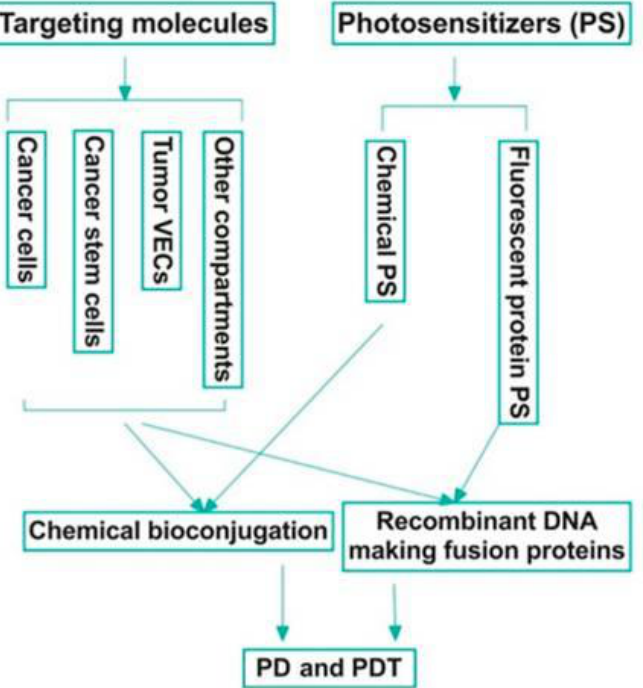
Figure 5. Bioconjugation strategies in photodiagnosis (PD) and therapy (PDT) of cancer. An ideal target, such as tissue factor (also known as CD142), should be commonly yet selectively expressed by multiple tumour compartments, including but not limited to cancer cells, cancer stem cells, and tumour vascular endothelial cells (VCEs), whereas it is negatively, minimally, or restrictedly expressed in normal cells. A potentially new bioconjugation strategy is the use of recombinant DNA techniques to produce fusion proteins that contain a targeting domain and a fluorescent protein PS simultaneously for targeted PD and PDT. Reproduced with permission from S. Gomez et al., Molecules; published by MDPI, 2020 [125].